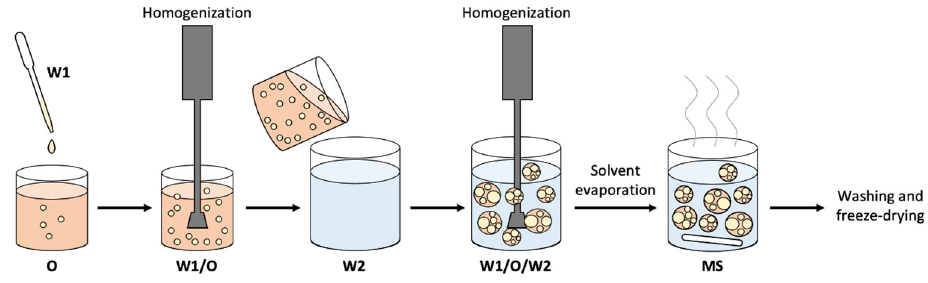
Figure 1. Exemplary scheme of the double-emulsion technique (W1/O/W2) used for the microsphere development.